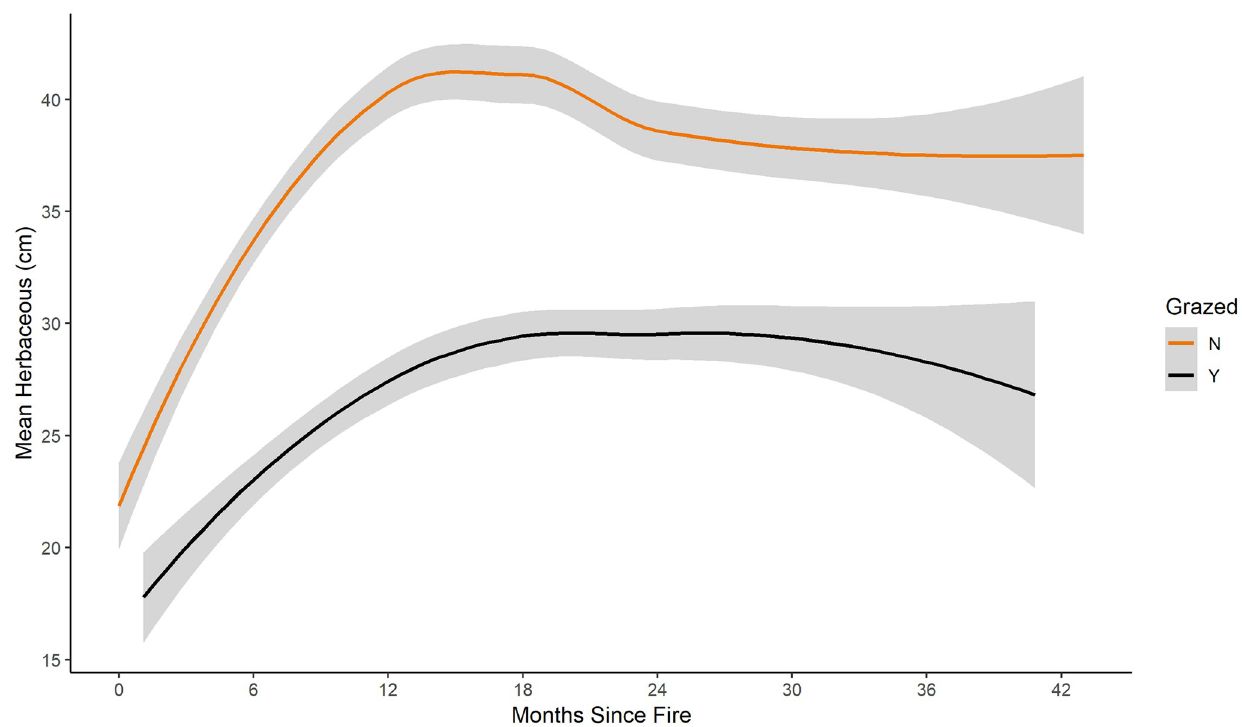
Fig 6. Mean herbaceous vegetation. Mean height (cm) of herbaceous vegetation in fire-only (orange) and pyric herbivory (black) treatments at all sites from 2014 to 2016. Shaded area indicates 95% confidence interval. � Regression lines and confidence intervals generated using “loess” locally-weighted smoothing